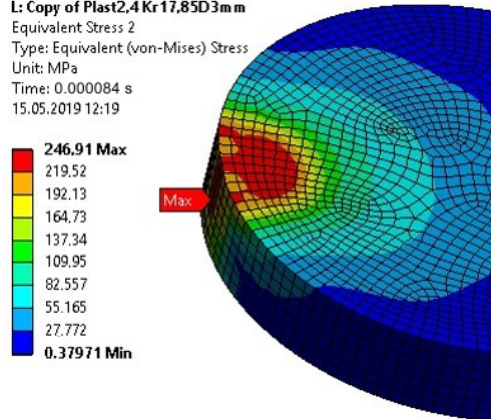
Figure 17. The von Mises Stress in the upper element of the specimen for the computation time equal to 0.000084 s—Model no. 2 (nonlinear analysis).